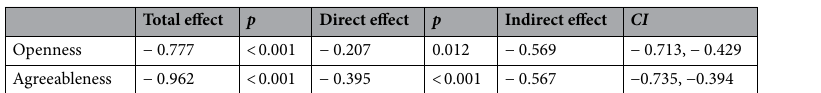
Figure 1. Mediating effect of perceived dangerousness on the relationship between personality and desire for social distance. Indices in bold represent agreeableness; those in italics represent openness. * p < 0.001 , # p = 0.012.